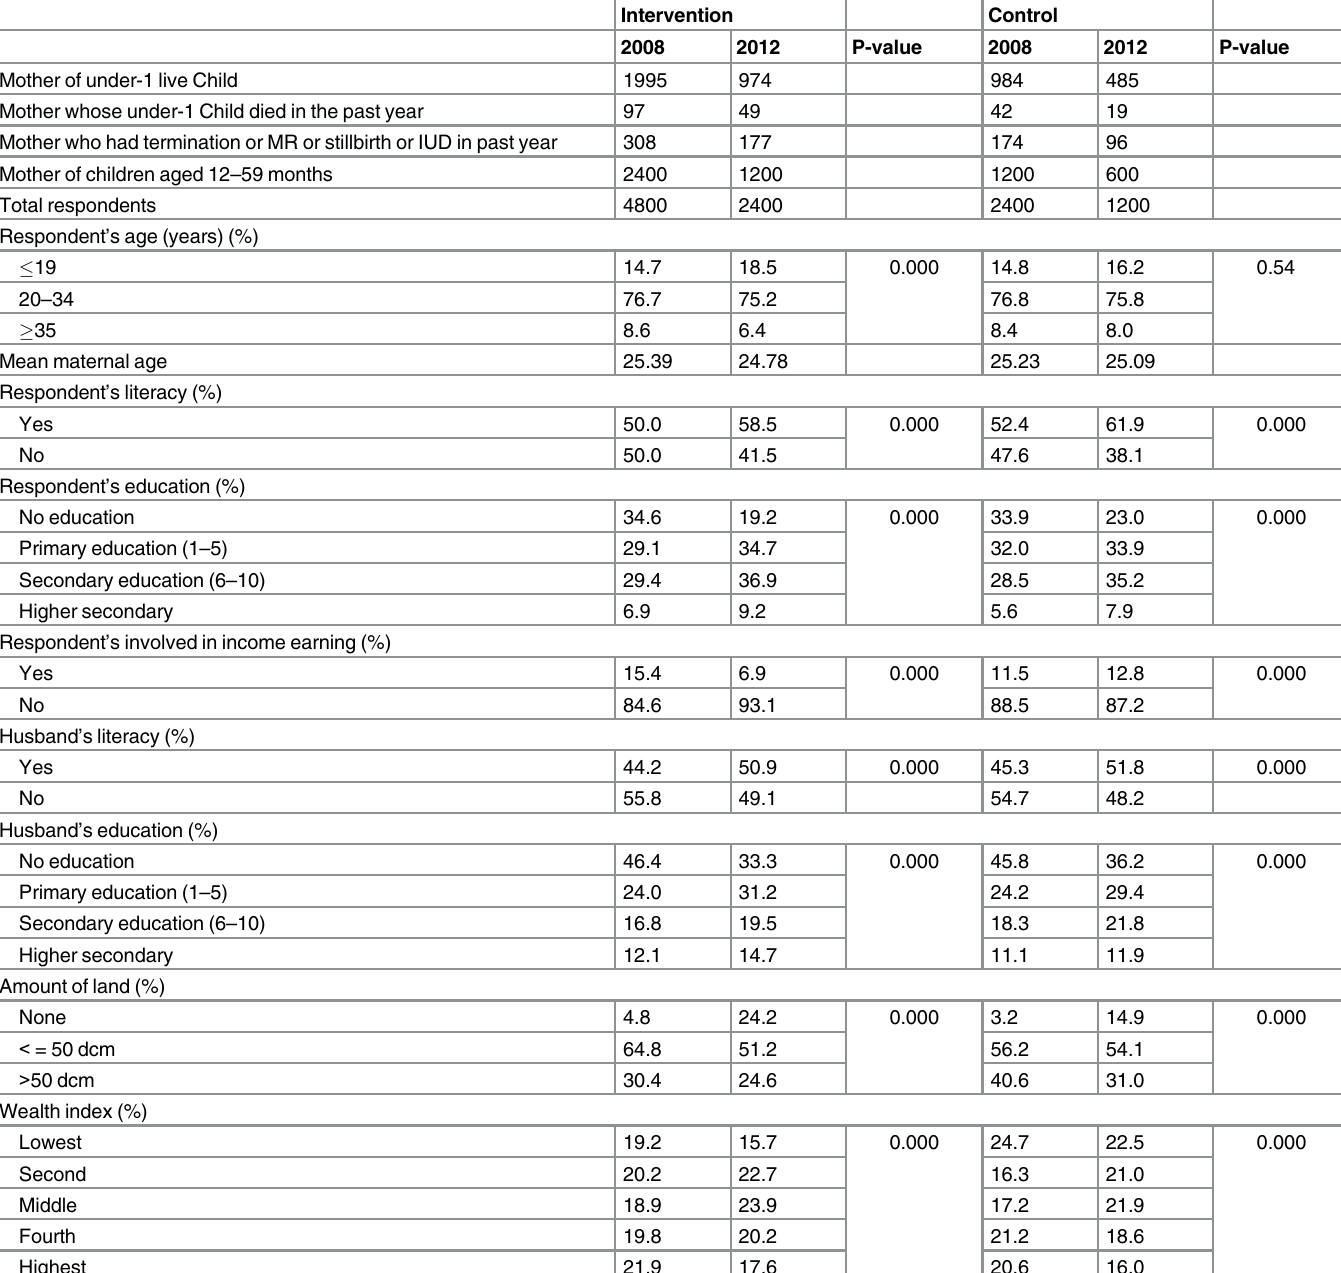
Table 2. Respondents ’ socioeconomic characteristics before and after the intervention.